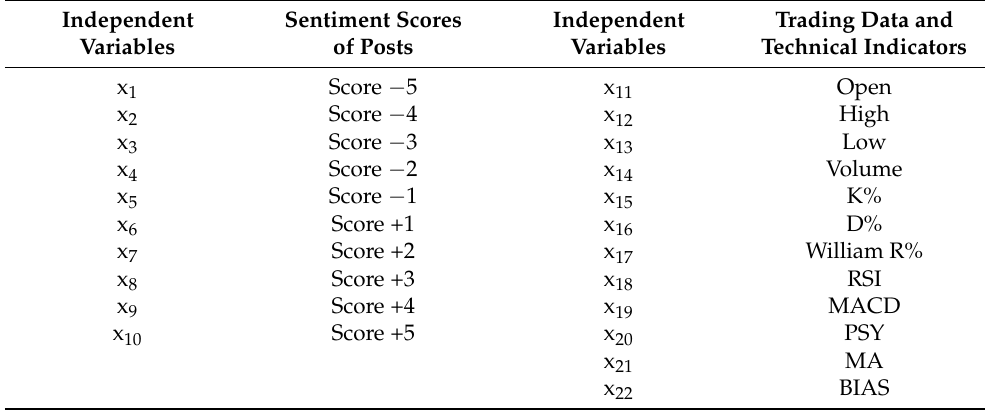
Table 4. Independent variables used in this study.